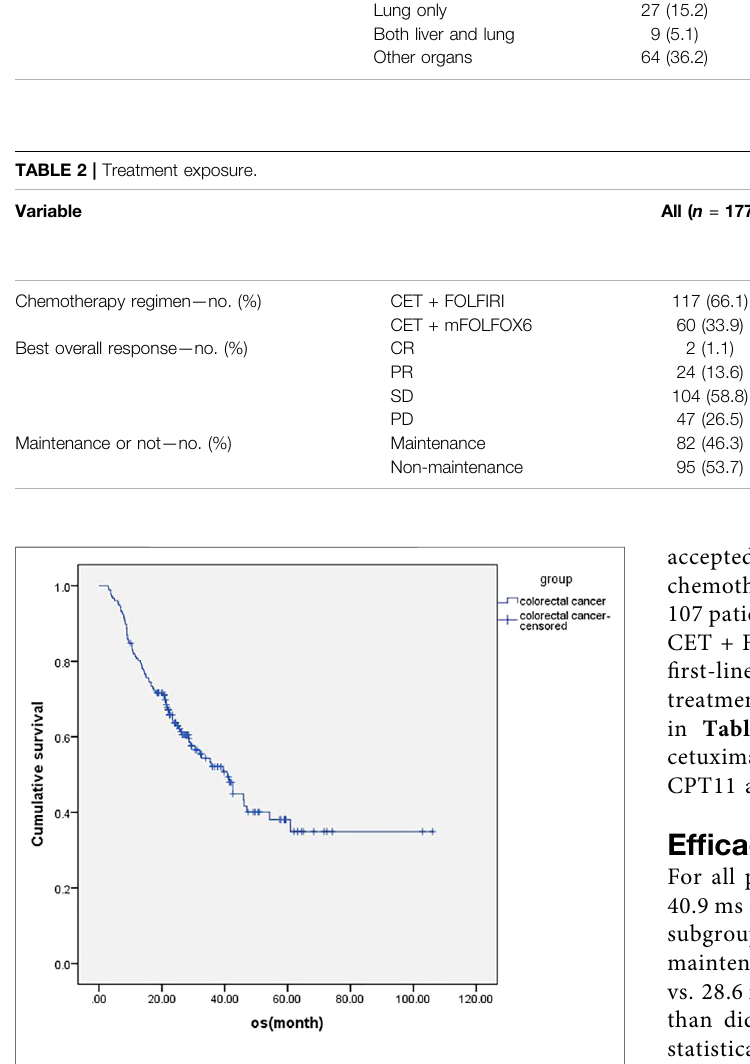
FIGURE 1 | overall survival of all the metastatic colorectal cancer patients ( n (cid:1) 177).